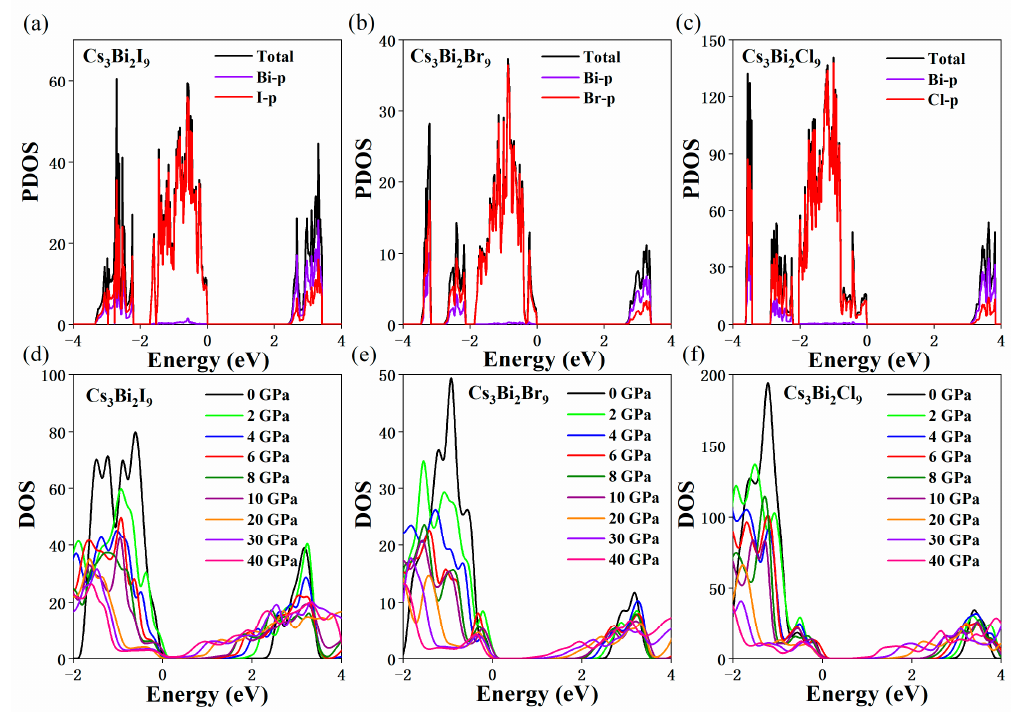
Figure 8. Partial state of density (PDOS) of Cs 3 Bi 2 I 9 ( a ), Cs 3 Bi 2 Br 9 ( b ), and Cs 3 Bi 2 Cl 9 ( c ). the VBM of the Cs 3 Bi 2 X 9 perovskites (X = I, Br, and Cl) is dominated by the p-X states, and the CBM is dominated by the p-Bi and p-X states. Calculated density of states (DOS) of the Cs 3 Bi 2 I 9 ( d ), Cs 3 Bi 2 Br 9 ( e ), and Cs 3 Bi 2 Cl 9 ( f ) under the pressures from 0 to 40 GPa.